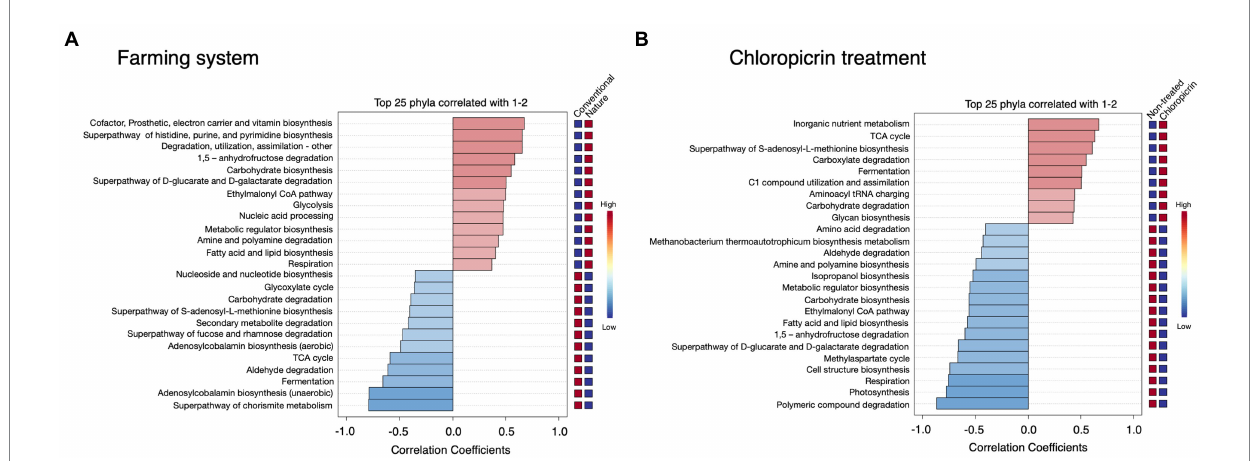
FIGURE 5 Putative functional prediction of bacterial communities in the rhizosphere of soybean grown under different farming systems (A) , and the treatment of chloropicrin (B) using PICRUSt. The top 25 significantly dominant functional pathways are